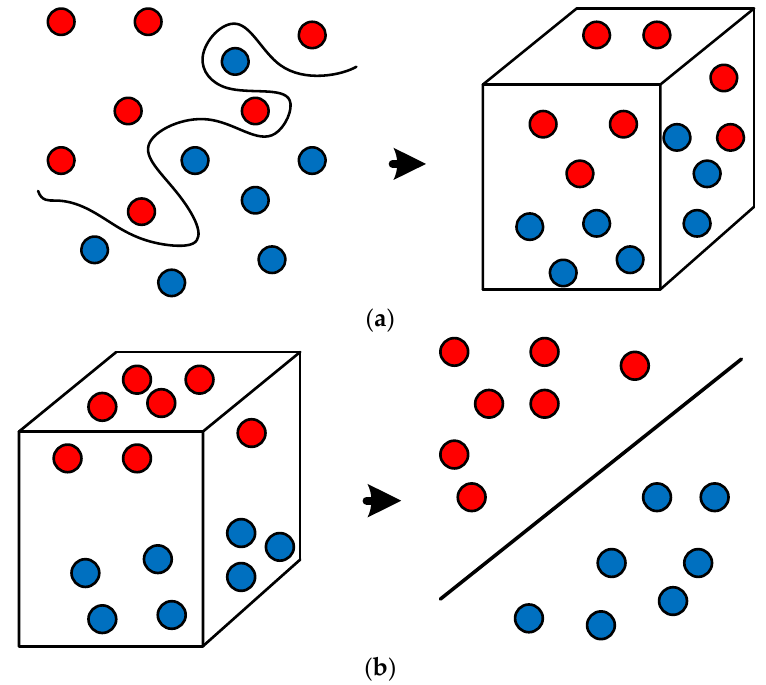
Figure 8. ( a ) Low-dimensional space to the high-dimensional space; ( b ) divide the sample, and then map it back to the low-dimensional space.